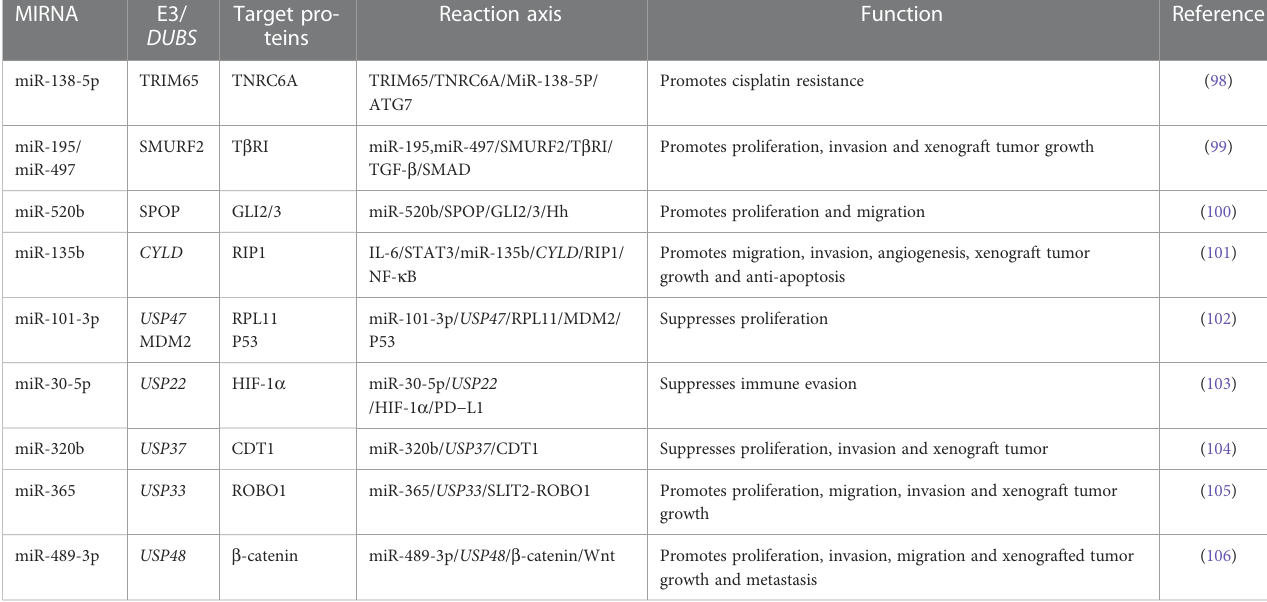
TABLE 1 The interaction between miRNAs and UPS in NSCLC.